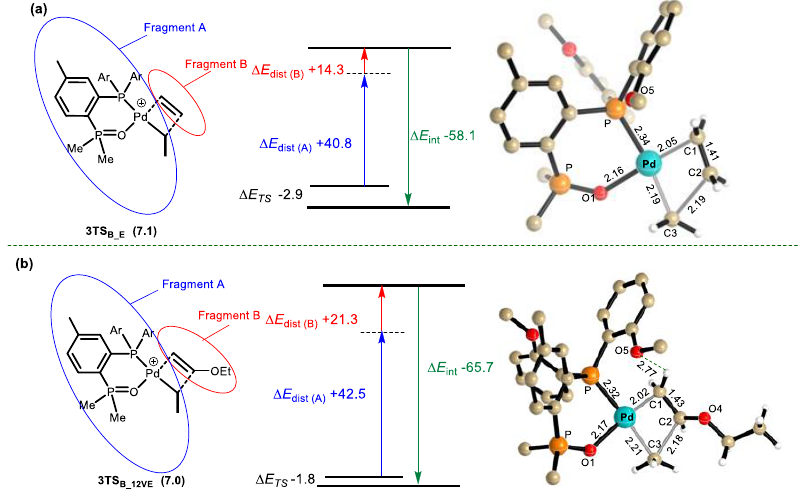
Figure 9. Distortion / interaction analysis of the transition state of ( a ) 3 TS B_E and ( b ) 3TS B_12VE . All energies are calculated in kcal / mol unit and atomic distances are measured in Å. Hydrogen atoms of the catalyst’s ligand have been omitted for clarity.